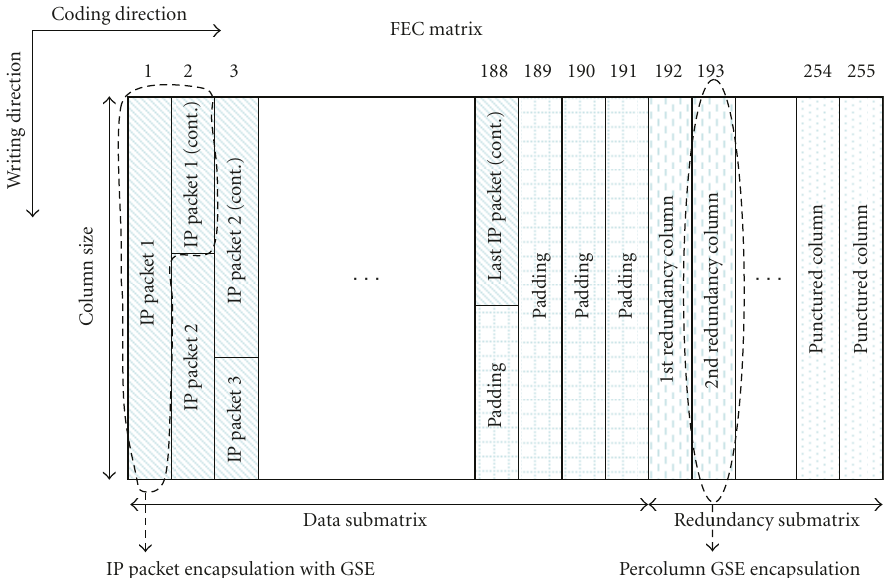
Figure 7: Arrangement of IP packets for FEC